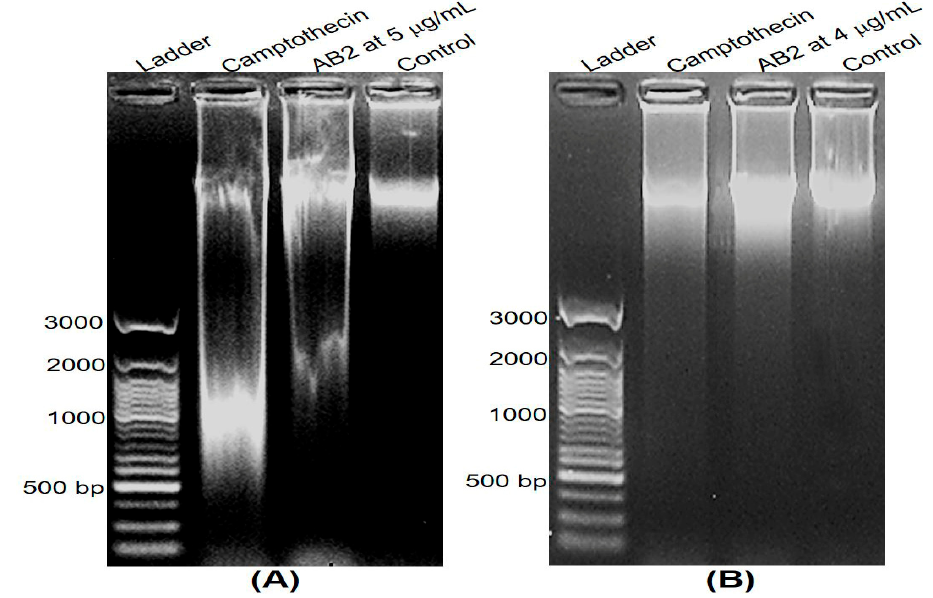
Figure 6. Apoptosis induced by 5,4’-dihydroxy-6,7,8,3’-tetramethoxyflavone at its IC 50 in HepG2 ( A ) and NCI-H460 ( B )